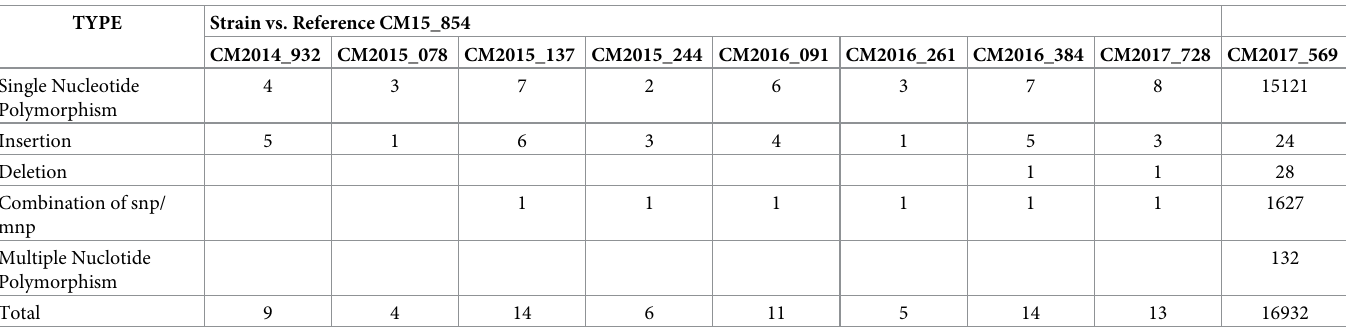
Table 3. SNP analysis of the group of MDR Serratia spp. isolates and comparison with their closest relative in our collection, strain CM2017_569.